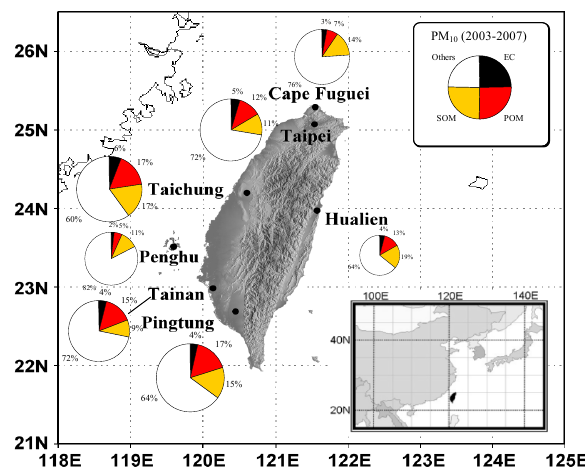
Fig. 4. Mean contributions of EC, POM, and SOM to the mass concentrations of PM 10 at the respective stations over Taiwan from 2003 to 2007. The area of each pie is proportional to the mass